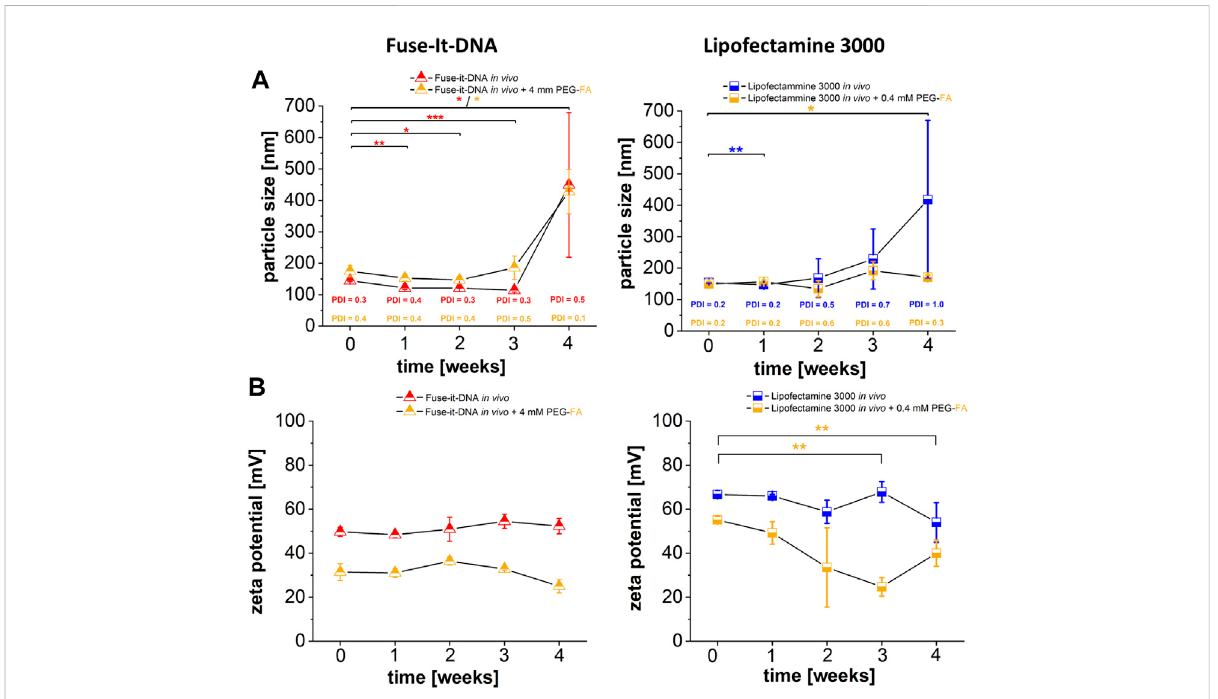
Characterization of PEG-FA functionalized lipoplexes. Physicochemical characterization of FA functionalized complexes compared with unmodi fi ed lipoplex-variants are shown in (A) (particle size) and (B) (zeta potential). n = at least three independent